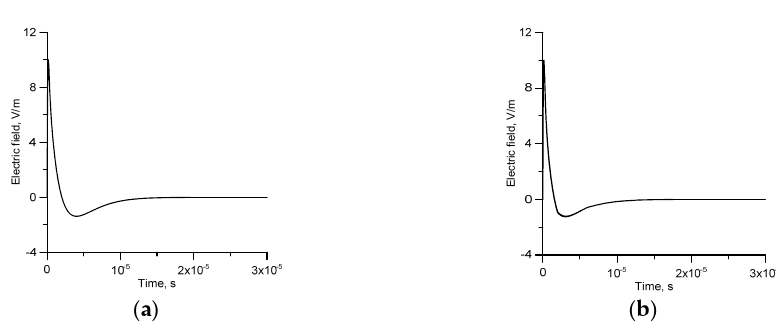
Figure 8. NBPs calculated using the growth curve given by Equation (34). ( a ) electric field is calculated assuming that the negative charge remains where it is generated with τ r = 0.1 µ s, τ d = 4.0 µ s; ( b ) electric field is calculated assuming that the negative charge propagates backward towards the streamer origin with τ r = 0.1 µ s, τ d = 4.0 µ s and τ n = τ d . In both examples, the value of n 0 was selected to make the electric field normalized to 100 km equal to 10 V/m. The speed of propagation of the forward moving and backward moving current is selected to be 3 × 10 7 m / s. The number of elementary charges at the streamer head is assumed to be 10 9 .